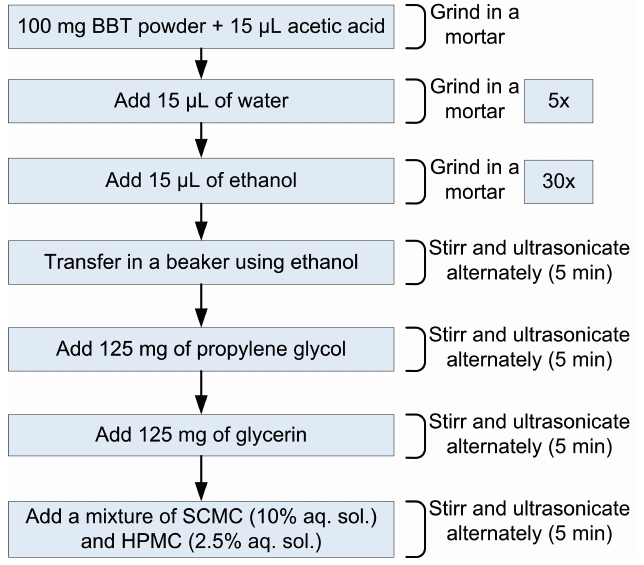
Figure 4. Scheme of the paste preparation from nanocrystalline BBT